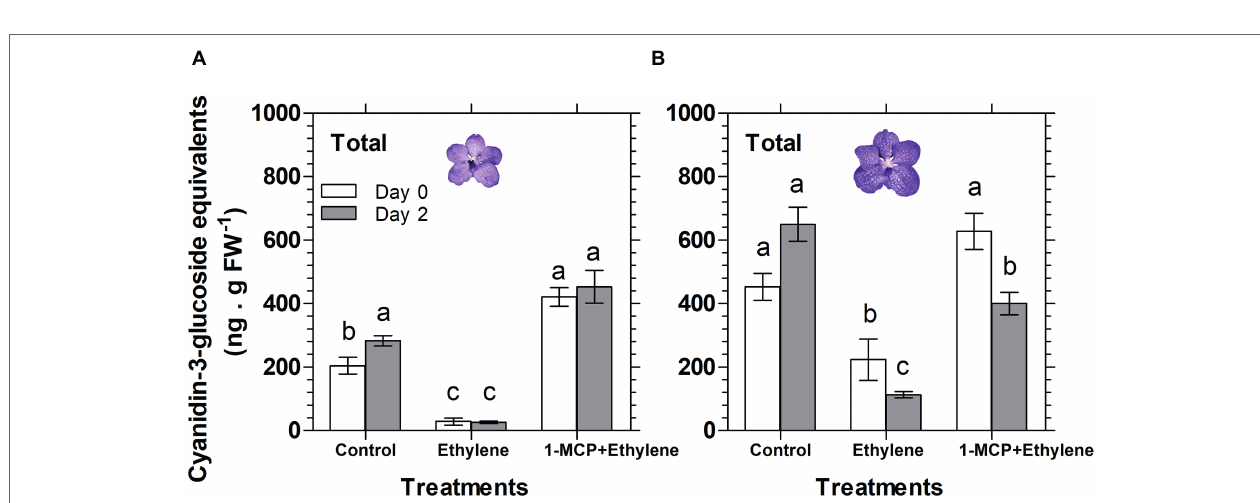
FIGURE 5 | Effect of ethylene and 1-MCP pre-treatments on changes, detected 2 days after treatments, in the content of total anthocyanins extracted from florets at half bloom (A) or bloom (B) developmental stages, based on the chromatogram peak areas of non-hydrolyzed samples of Vanda ‘Sansai Blue’ florets. Ethylene and 1-MCP pre-treatments were applied as detailed in Figure 2 , and the anthocyanin level was calculated as cyanidin-3-glucoside equivalents. The results represent means ± SE of three floret replicates per treatment, and different letters indicate significant differences among treatments at the different time points, at p <